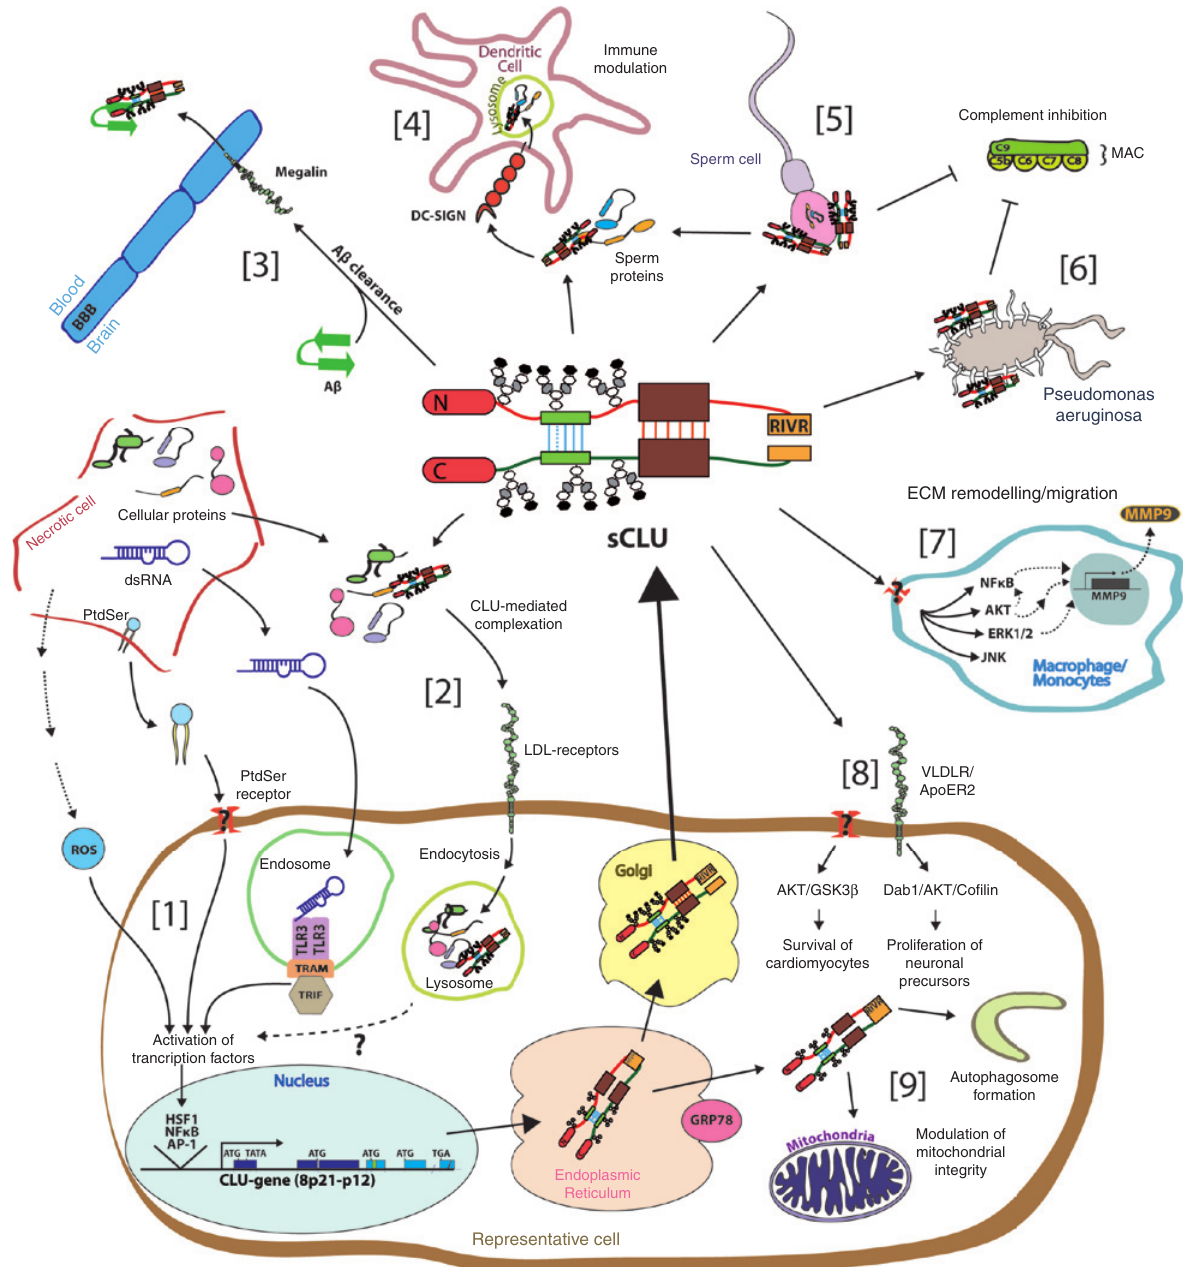
Figure 3: Role of CLU in cell biology, pathology, immunobiology and beyond. For description please see